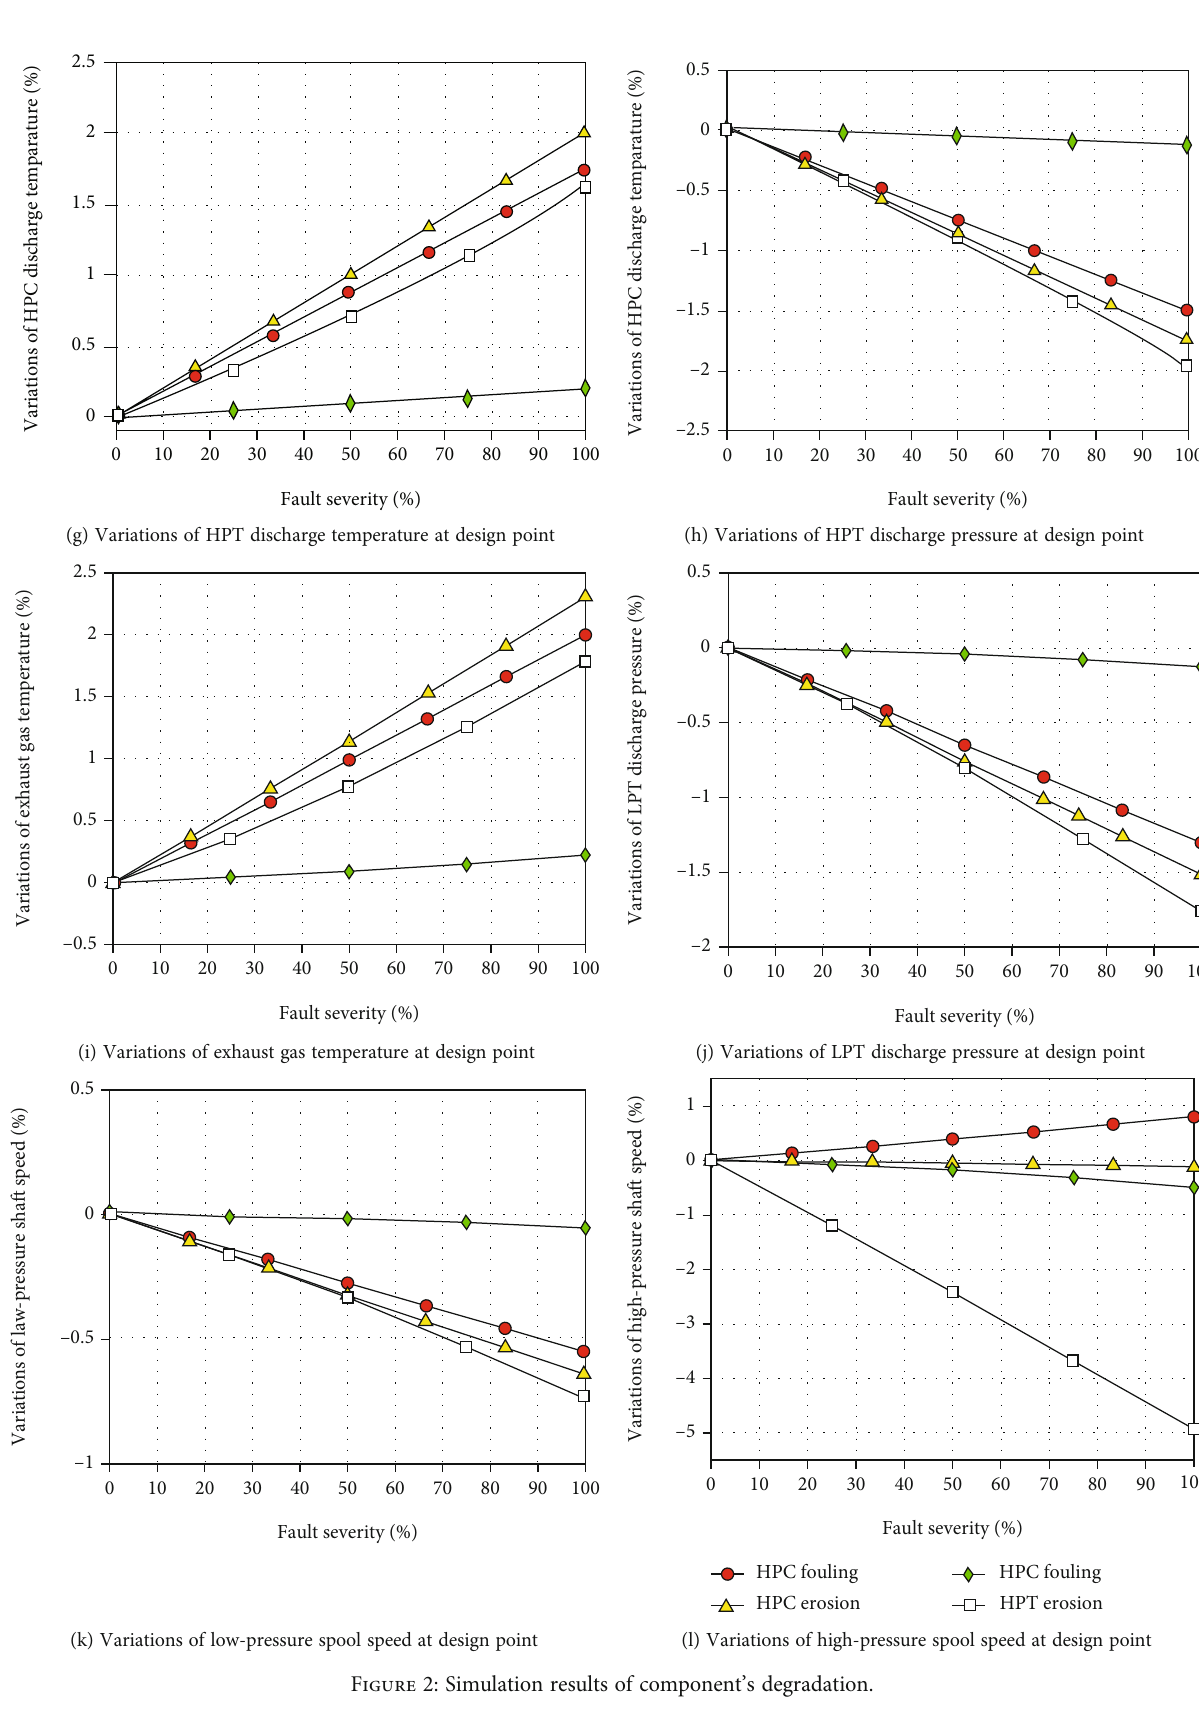
Figure 2: Simulation results of component ’ s